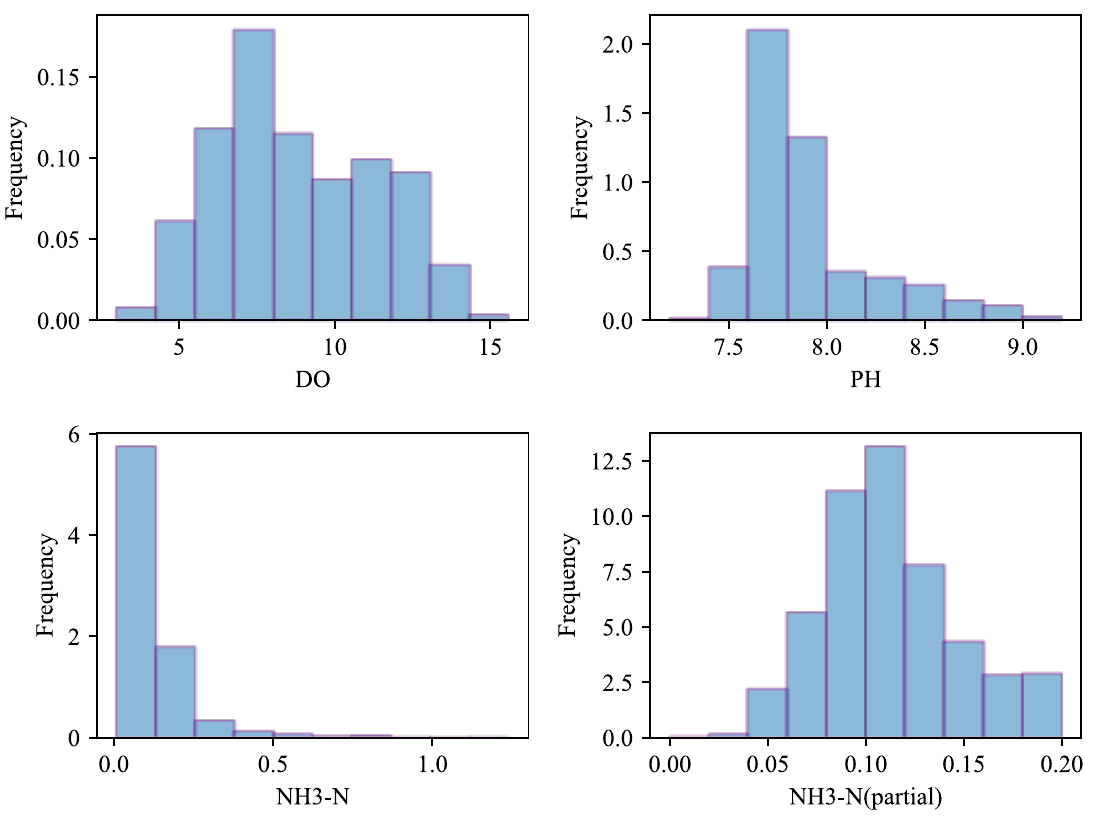
Figure 1. Frequency distribution of water quality indicators.